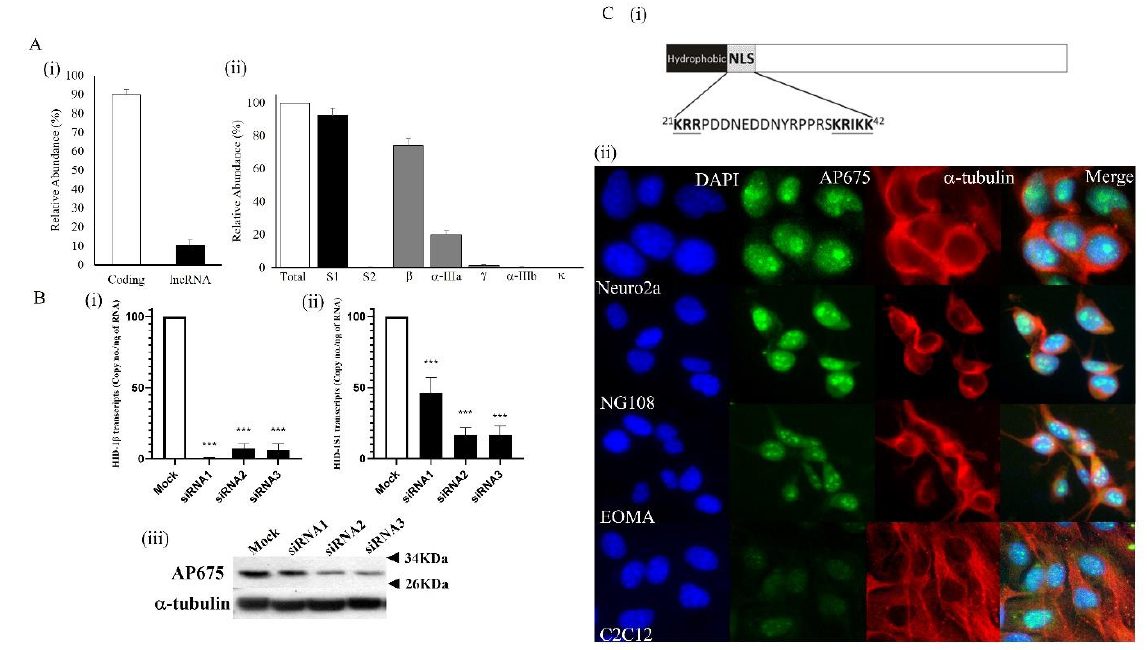
Figure 3. Characterization of Tmem29 protein in mouse cell lines. ( A ) Characterization of Tmem29 expression in Neuro2a cells by absolute quantification of (i) coding and lncRNA Tmem29 transcripts, and (ii) different splice variants. Individual subgroup (S1, S2) and different splice variants’ relative abundance was referenced to total Tmem29 mRNA and expressed in percentage; ( B ) Detection of Tmem29 protein in siRNA knockdown Neuro2a cells. (i) Quantification of Tmem29 β (ii) Tmem29- S1 subtype transcripts in Neuro2a cells. (iii) Immunoblot of AP675 in siRNA-transfected Neuro2a cell lysate. Data were expressed in mean ± standard deviation with 6 individual mice and experiments were done in triplicate. *** p < 0.001; ( C ) Cellular localization of Tmem29 protein in Neuro2a, NG108, EOMA, and C2C12 cells. (i) Predicted NLS sequence of Tmem29 protein. (ii) Representative immunostaining by AP675 in different cell lines. Morphology was captured at 400x magnification.